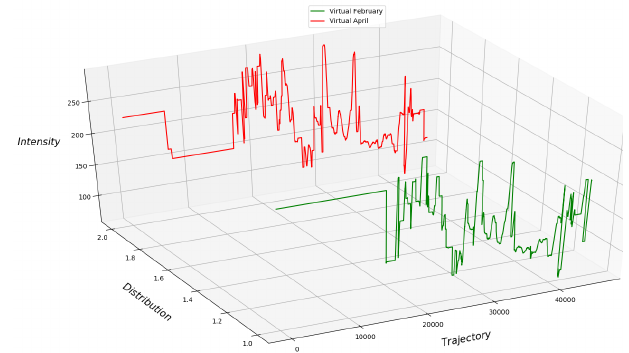
Figure 17. Measured light values for the Pites Sibiu) segment of A1-DN7